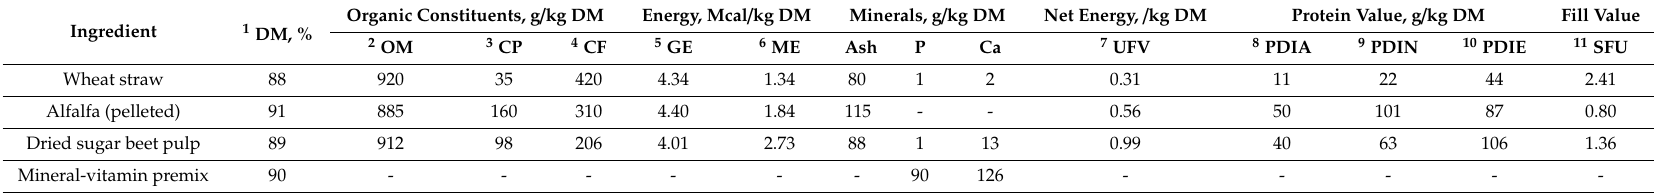
Table 1. Nutritive value of ingredients included in the experimental diets.